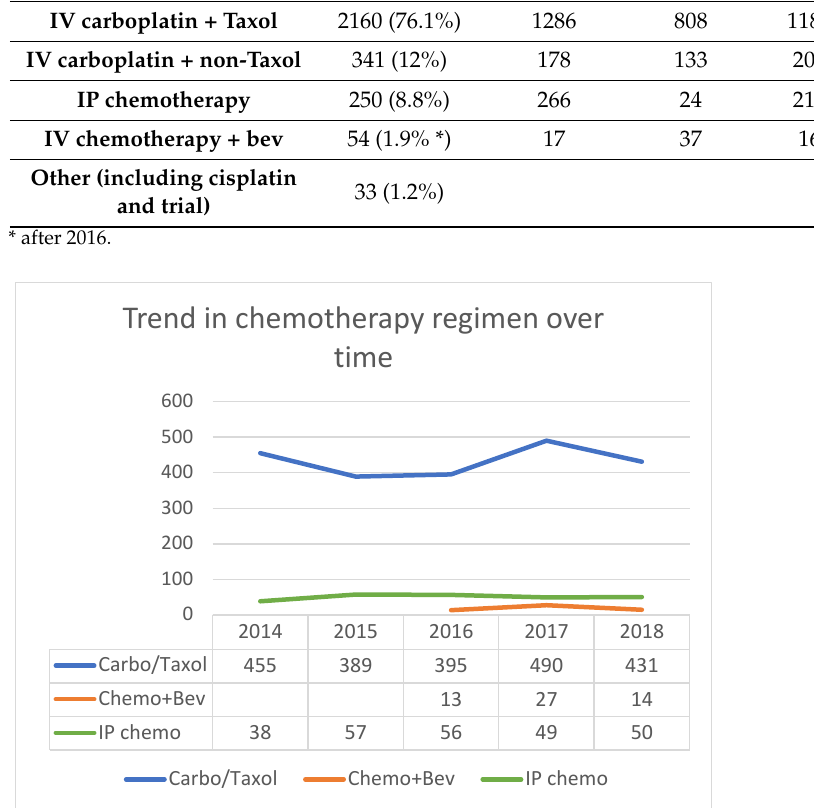
Figure A8. Chemotherapy regimen by year.